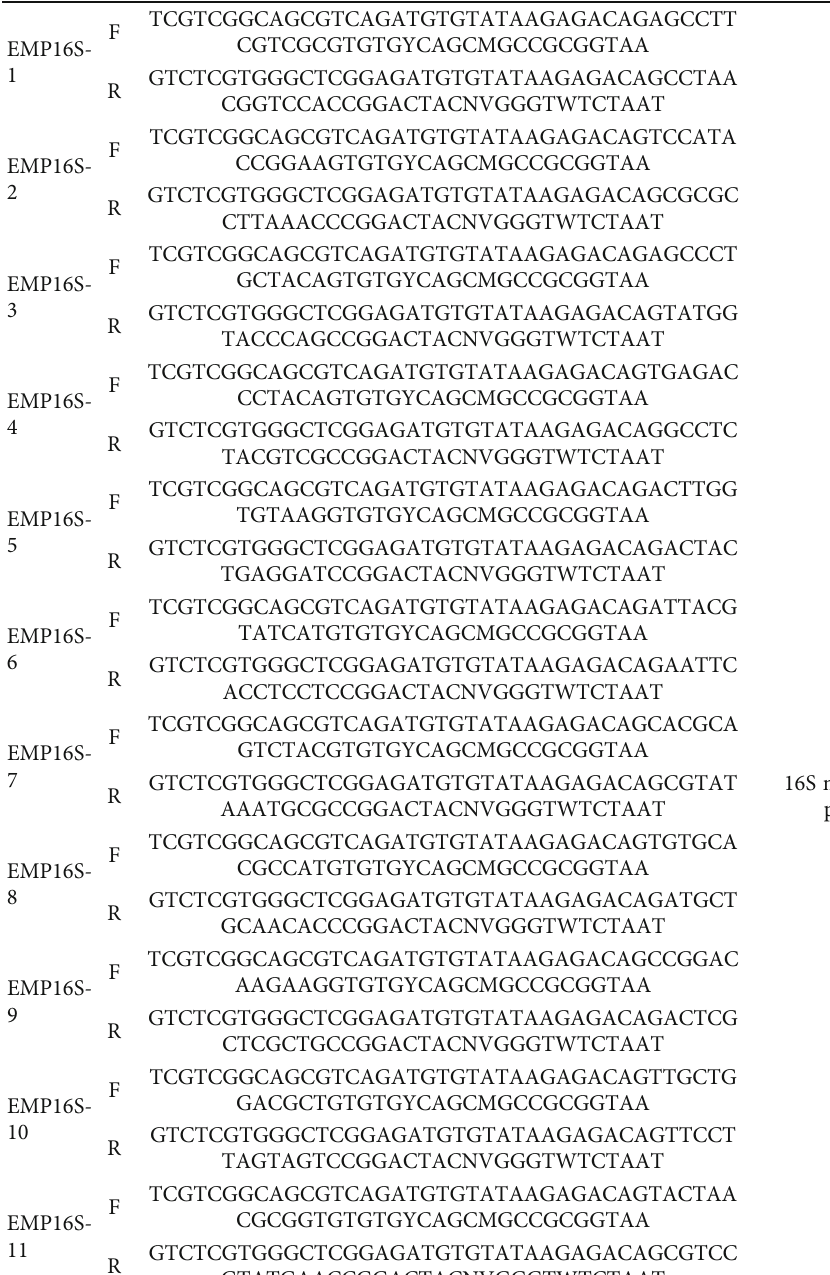
Table 1: List of